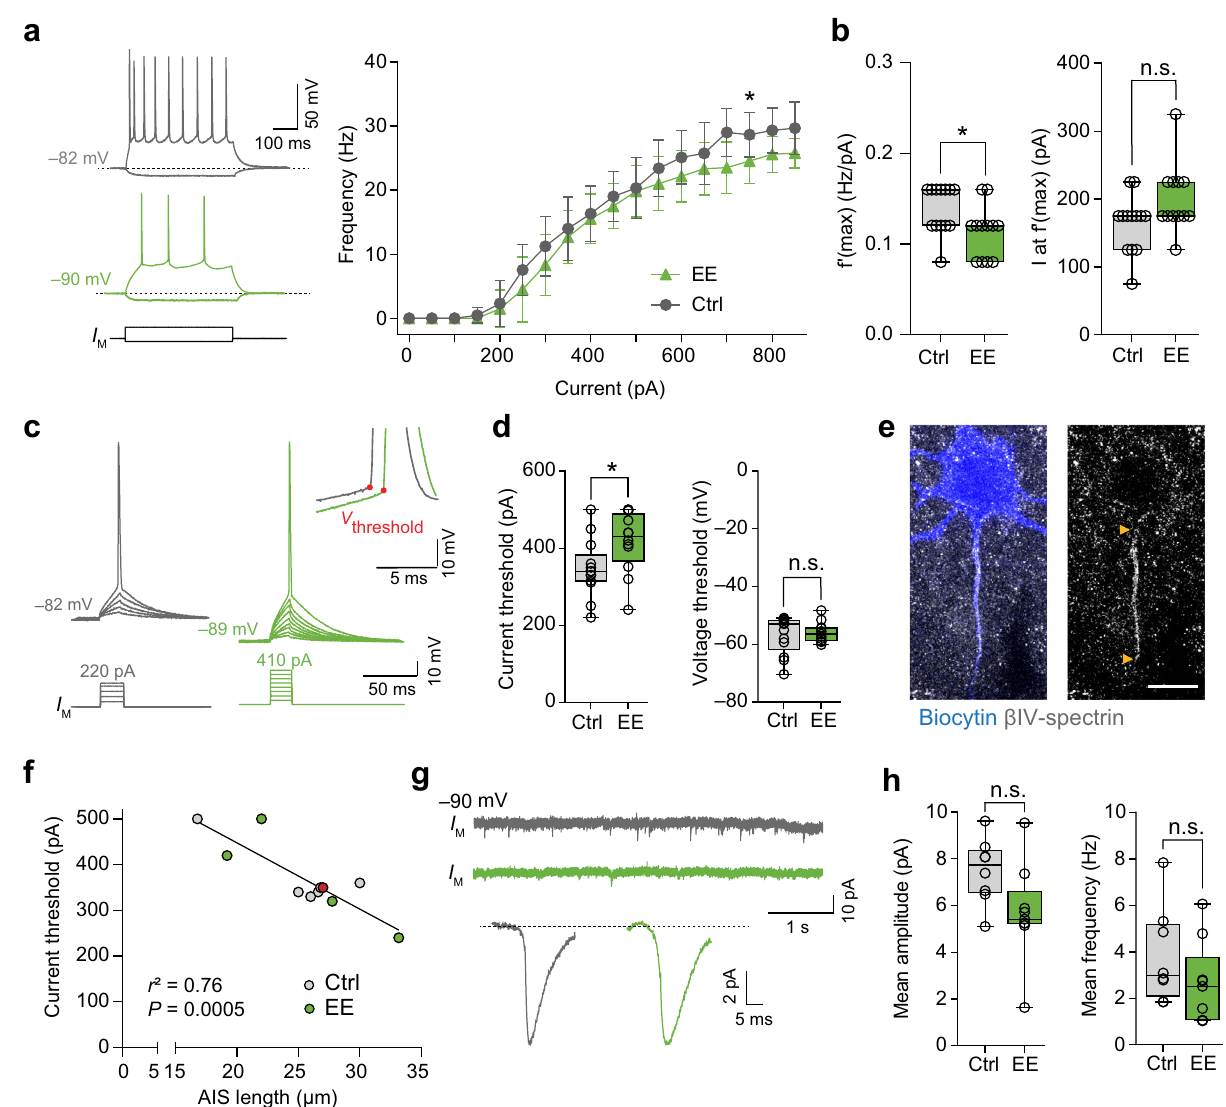
Fig. 5 Decreased excitability of layer II/III pyramidal neurons after 3 h enriched environment (EE). a Left: Representative traces of AP trains elicited by current injection (500 ms, − 50 pA, + 250pA). Note the decreased fi ring frequency in the EE neuron (green trace). Right: Input/frequency relationship as determined by 500 ms long injections of increasing currents. The EE group showed signi fi cantly decreased fi ring frequencies (Two-way ANOVA (current x EE) *** P < 0.0001 for current injection and EE, P = 0.38 for the interaction, Sidak ’ s multiple comparison test * P = 0.035, n = 13 Ctrl cells, 12 EE cells from 10 biologically independent experiments). Data are presented as mean ± SD. b Analysis of maximum slope f ’ (max) of the I - f curve and current at the maximum slope I at f ’ (max) for the respective neuron. f ’ (max) was signi fi cantly lower in the EE group (unpaired two-sided t -test *P = 0.032). I at f ’ (max) was unchanged (unpaired two-sided t -test P = 0.058 n = 13 Ctrl cells, 12 EE cells from 10 biologically independent experiments). c Representative traces of single APs elicited by 20 ms current injections; 10 pA increments of injected current used to determine AP current and voltage threshold (inset). d Analysis of current and voltage threshold for threshold APs. EE neurons had signi fi cantly higher current threshold (unpaired two-sided t -test * P = 0.033). Voltage threshold was unchanged (Mann – Whitney test P = 0.73, n = 13 Ctrl cells, 12 EE cells from 10 biologically independent experiments). e Representative confocal image of an EE neuron fi lled with biocytin (blue) for AIS length analysis via colabeling with β IV-spectrin (gray). Arrowheads indicate start and end of AIS. Scale bar 10 µ m. f Correlation analysis of relationship between AIS length and current threshold. Results of linear regression analysis indicated in fi gure ( n = 11 cells from at least 6 biologically independent experiments). Red dot indicates example cell from image in e . g Representative traces of postsynaptic currents (PSCs) recorded at – 90 mV. Top trace shows 6 s of recording. Bottom trace shows the averaged detected PSCs across the entire recording session of 2 min. h Mean amplitude and frequency of PSCs. No signi fi cant difference was observed (unpaired two-sided t -test, amplitude: P = 0.058, frequency: P = 0.22, n = 8 Ctrl cells, n = 9 EE cells from at least six biologically independent experiments). Boxplots: median with 25 – 75% interval, error bars show minimum to maximum